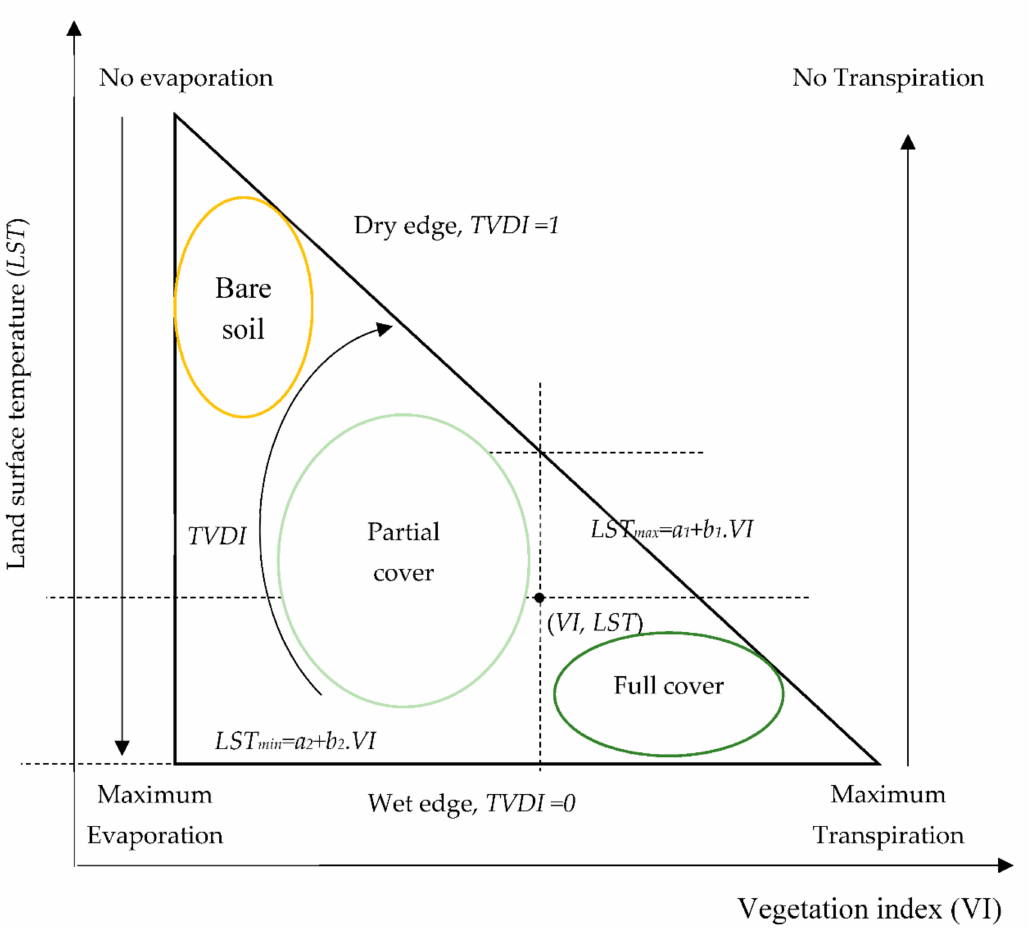
Figure 3. Definition of the TVDI in the LST/VI feature space. Adapted from [30,32]. 1. Reprinted with permission from ref. [30]. Copyright © 2001 Elsevier Science Inc. 2. Reprinted with permission from ref. [32]. Rights managed by Taylor &